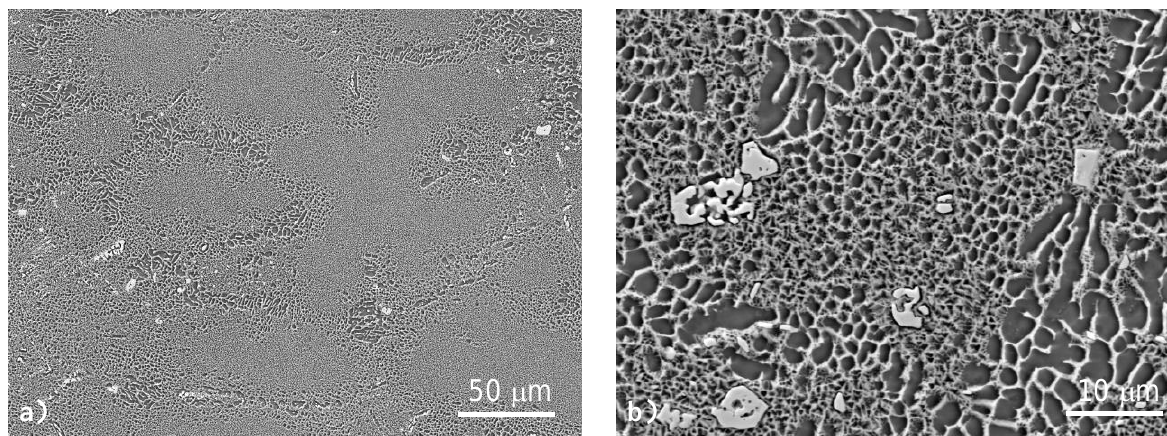
Figure 6: Microstructure of alloy G1 crept at 950 ∘ C and 400MPa at different magnification.